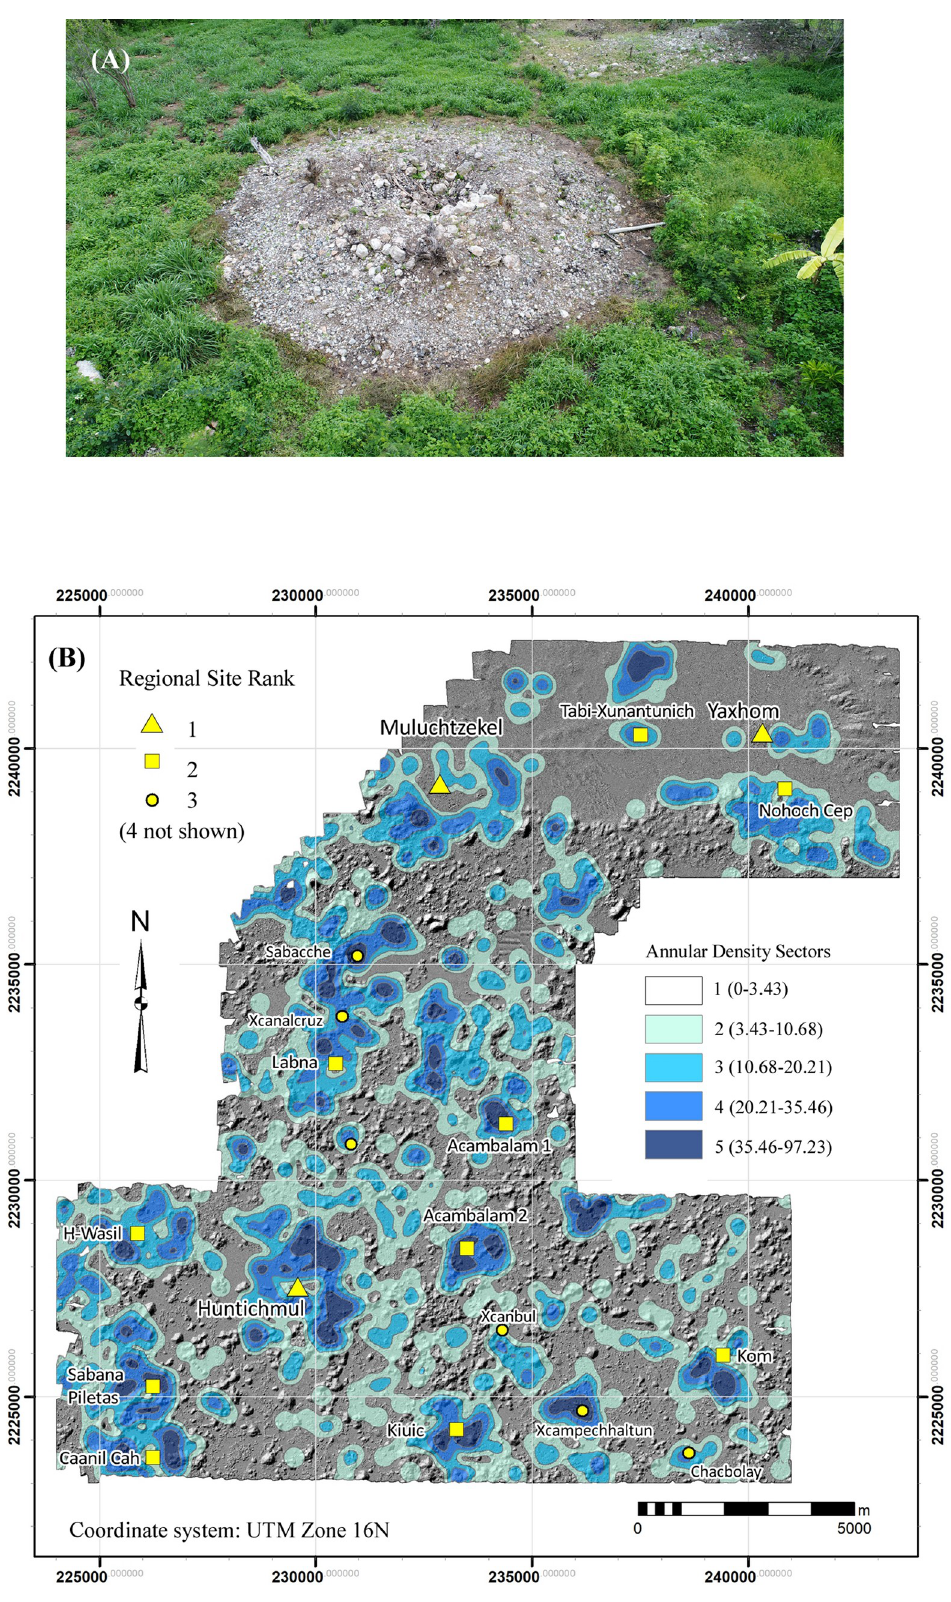
Fig 17. Annular structures. (A) An example of an annular structures. (B) density distribution of annular structures. https://doi.org/10.1371/journal.pone.0249314.g017 PLOS ONE | https://doi.org/10.1371/journal.pone.0249314 April 28,